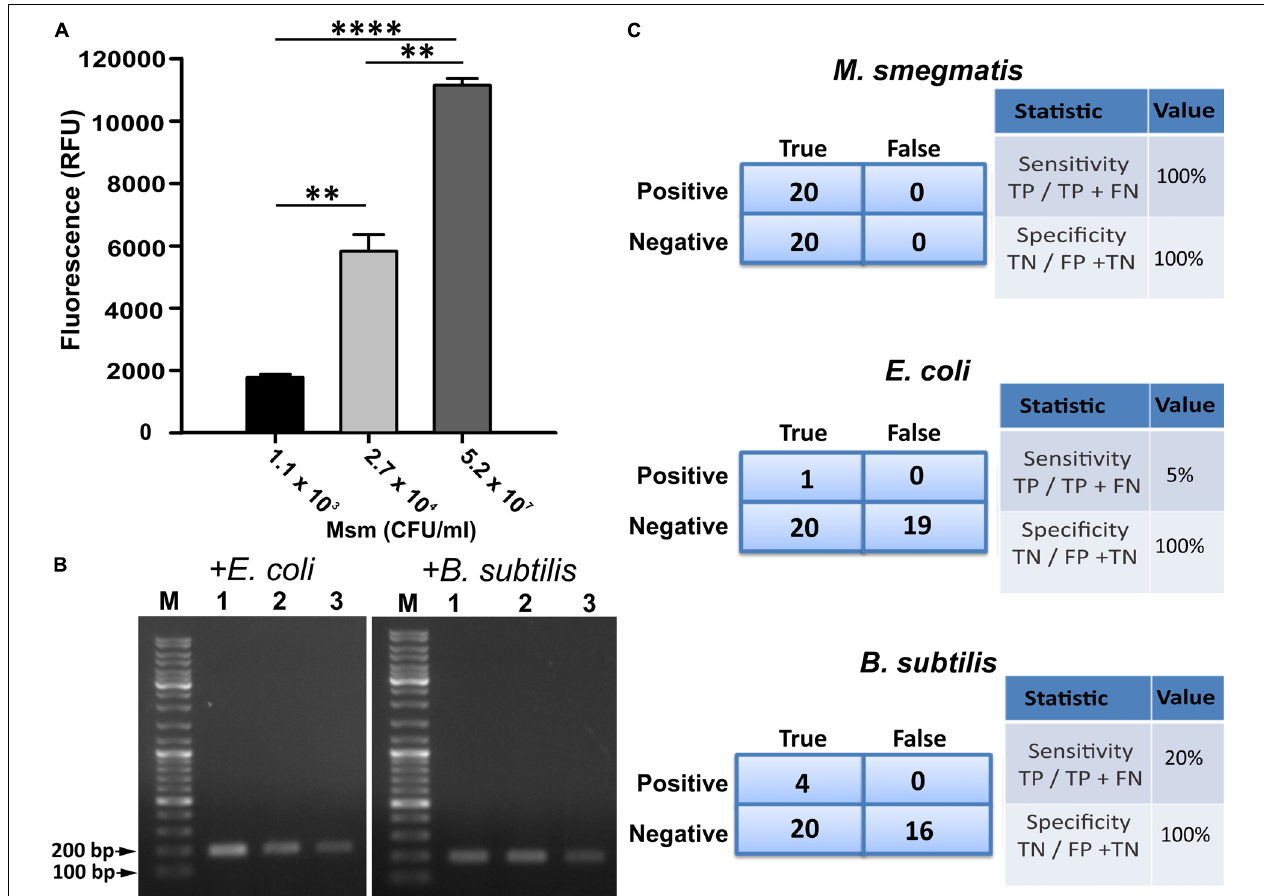
FIGURE 5 | Evaluation of efficiency of designed M. smegmatis detection assay. (A) CTD-GFP was used for differential quantitative assessment of the presence of M. smegmatis in bacterial samples carrying a mixture of varying amount of M. smegmatis cells spiked with E. coli and B. subtilis . x -axis represents the CFU/ml of M. smegmatis (Msm) present in the sample for assay and y -axis represents fluorescence obtained due to CTD-GFP binding to M. smegmatis cells ( P -value analysis: ∗∗∗∗ , < 0.0001; ∗∗ , < 0.0002). (B) Limit of detection of designed assay analyzed with minimal level of M. smegmatis spiked with either E. coli or B. subtilis as depicted above agarose gel images. Shown are the amplicons obtained by PCR carried out using mno gene primer. Lanes 1, 2, and 3 represent 1.1 × 10 3 , 2.7 × 10 4 , and 5.2 × 10 7 CFU/ml of M. smegmatis cells, respectively, present in the samples. “M” represents the DNA ladder with two bands marked. (C) Statistical analysis of the specificity and the sensitivity of the detection of M. smegmatis , E. coli , and B. subtilis , as depicted. Experiments were performed multiple times to obtain statistically significant data. “TP,” “TN,” “FP,” and “FN” represent true positive, true negative, false positive, and false negative,